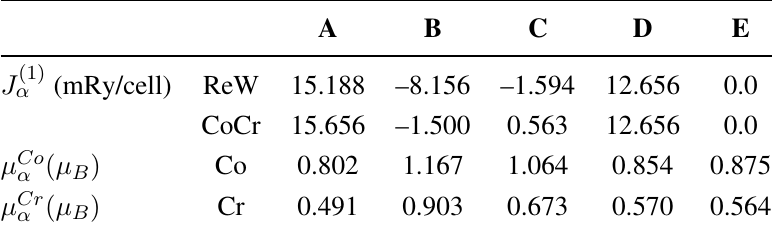
Table 2. On-site parameters J (1) systems within the DLM-LSF model at T = 1,400 K and T = 1,500 K respectively. µ Co µ Cr are the local magnetic moments of the Co and Cr atoms in the Co α the Re-W σ -phase is